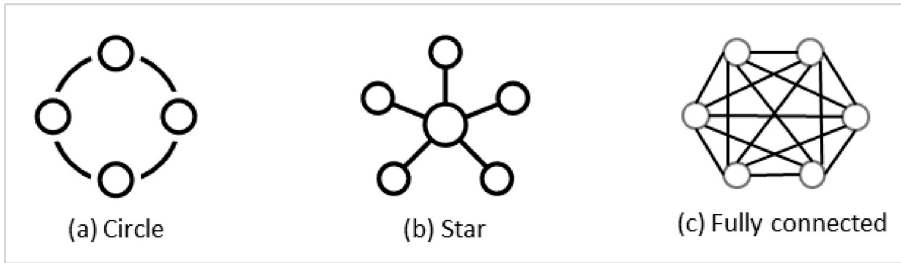
Fig 3. Three prototypical network